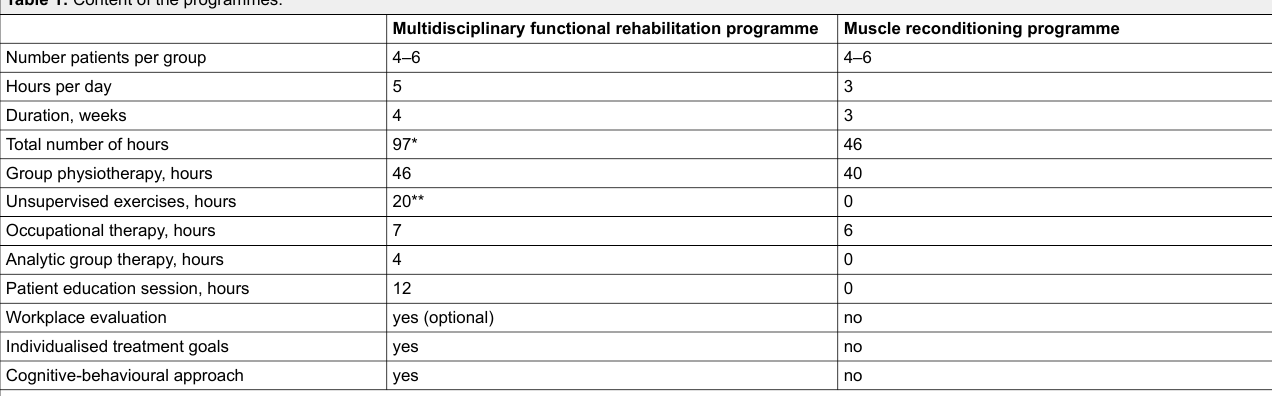
Table 1: Content of the